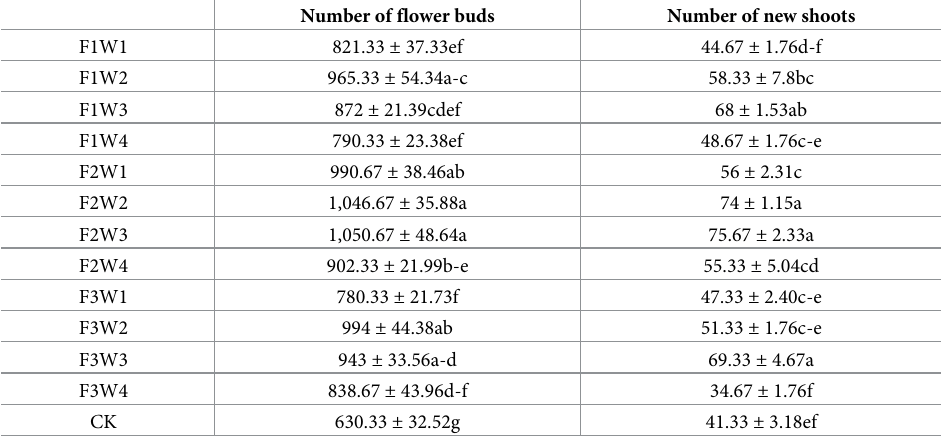
Table 4. Effects of different water and fertilizer treatments on the growth of blueberry flower buds.